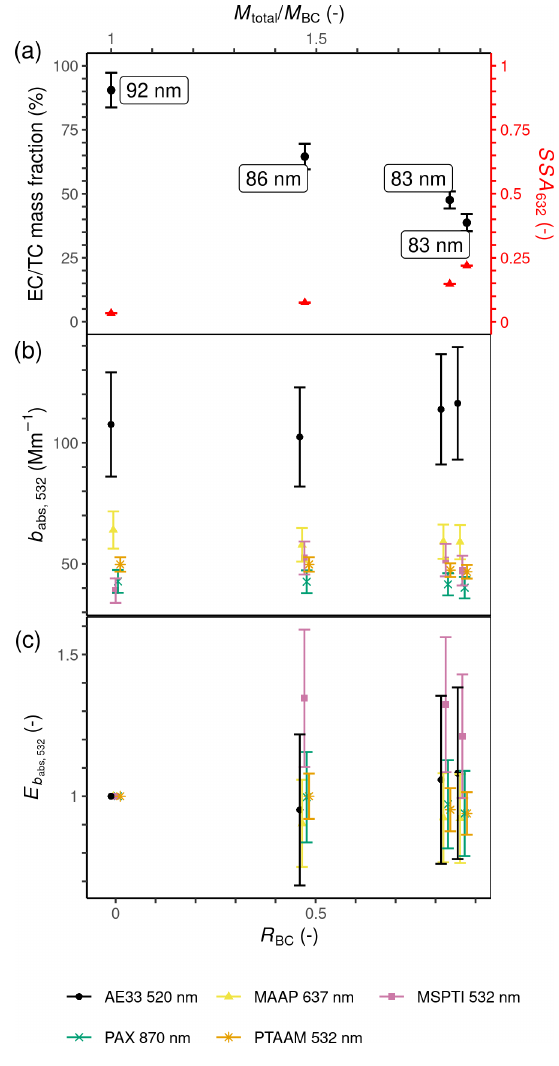
Figure 4. Measurements obtained with setup 1. (a) EC / TC mass fraction as a function of total mass to BC mass ratio and R BC . The total mass to BC mass ratio and R BC are based on TEOM measure- ments. The single-scattering albedo (SSA) at 637nm, calculated from b abs measured by the MAAP and the scattering coefficient measured by the nephelometer, is shown on the secondary y axis. The sample geometric mean diameter is shown as a label on each data point. (b) Absorption coefficient ( b abs ) as a function of total mass to BC mass ratio and R BC . All b abs values have been con- verted to a wavelength of 532nm using the absorption Ångström exponents determined from the b abs values from the PTAAM. The legend below Fig. 4c indicates the wavelengths at which the mea- surements were performed. All b abs values have also been scaled by the number concentration. The values are listed in Table S2. (c) Ab- sorption enhancement factor E b (532nm) as a function of total abs mass to BC mass ratio and R BC . The values are listed in Table S3. The data points in panels (b) and (c) have been slightly shifted along the x axis to improve the readability of the graph. The error bars designate measurement uncertainties for k = 1 (68% confidence in- terval). The uncertainty ( k = 1) in R BC is estimated to be about 5% (not